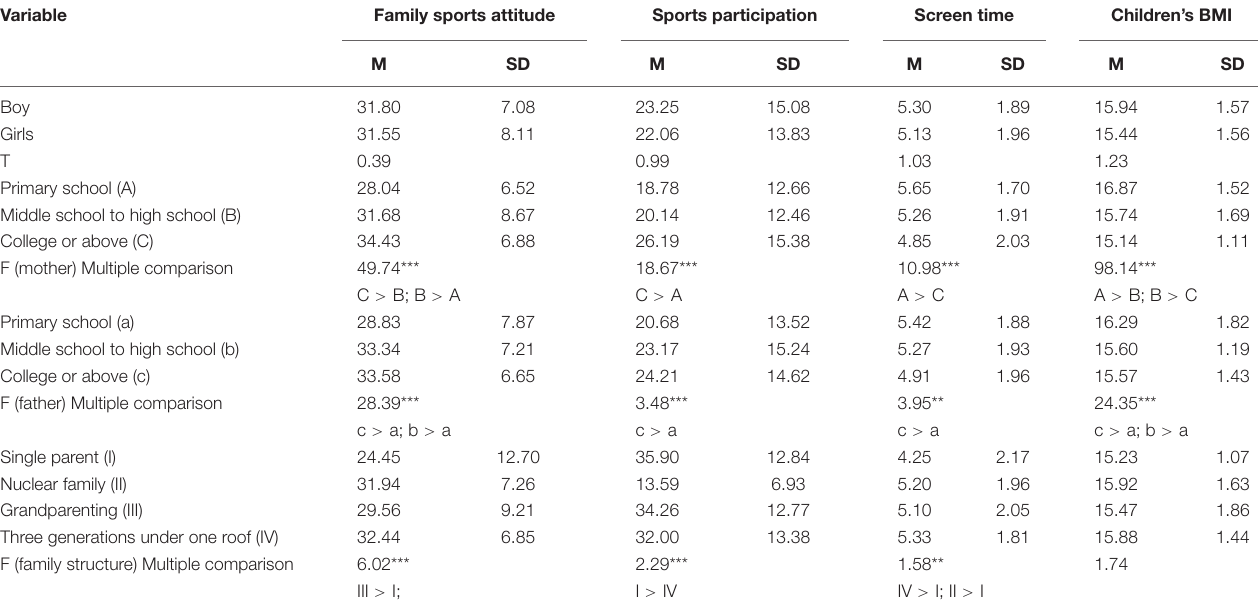
TABLE 2 | Demographical variance analysis of sports attitude and sports behavior ( N =